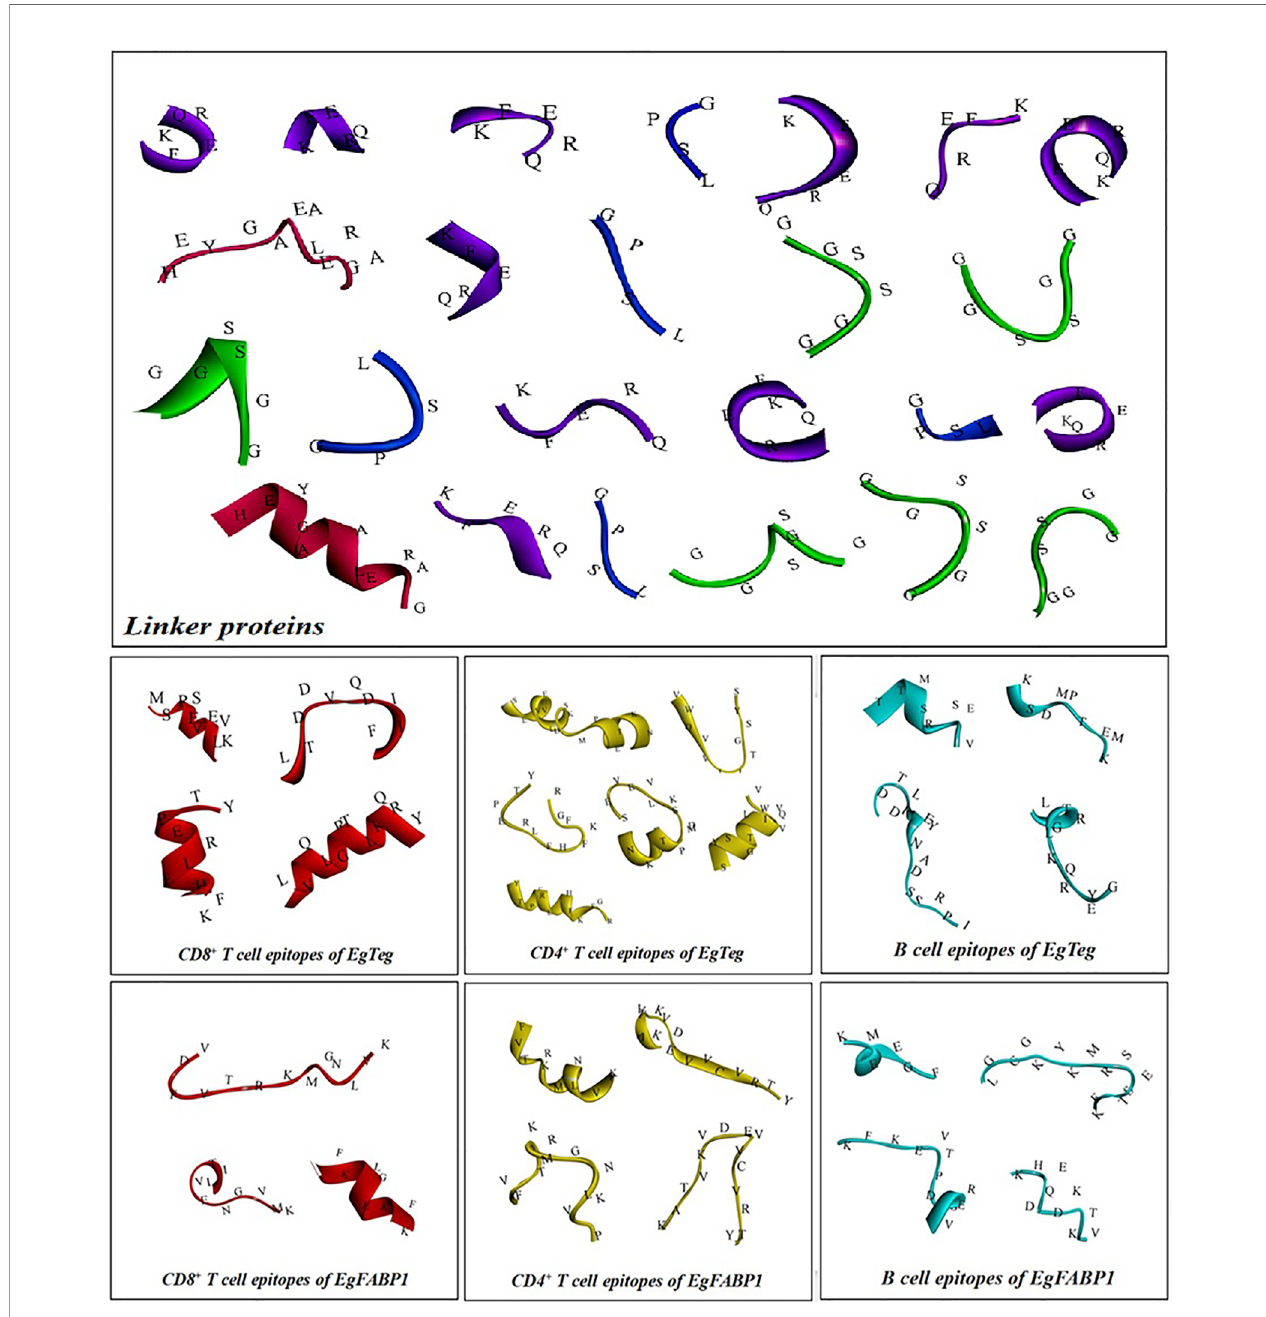
FIGURE 5 | The linker proteins and antigen epitopes in the